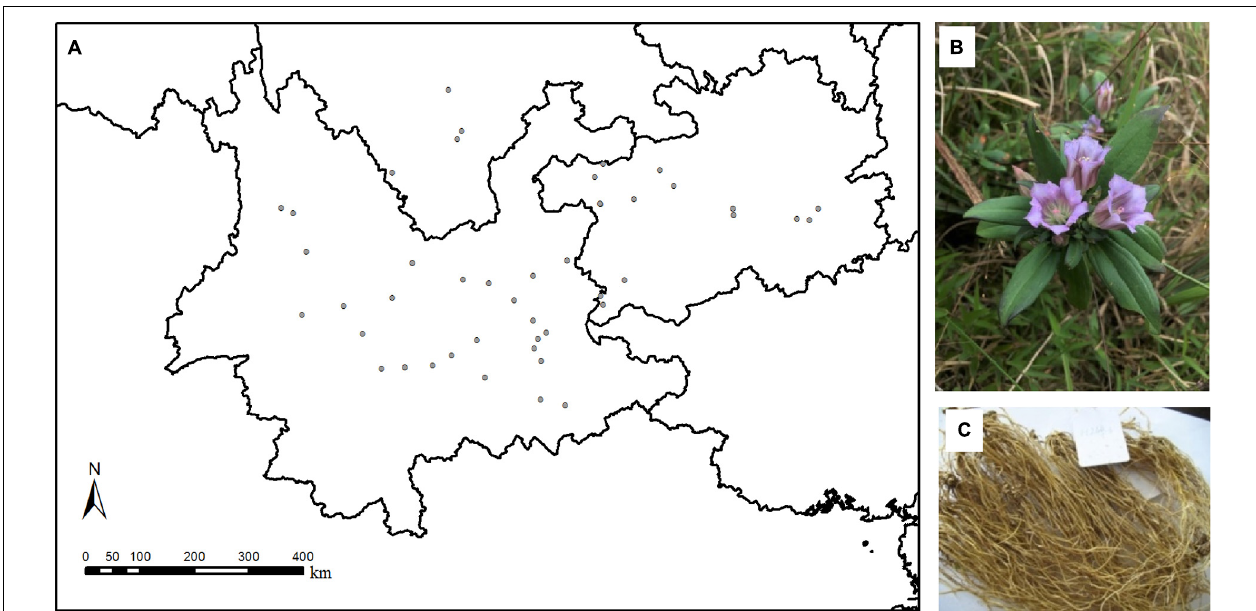
FIGURE 1 | Sampling sites and samples of Gentiana rigescens . (A) Sampling sites of the plant species in southwest of China. (B) Above-ground part of the plant species. (C) Below-ground part of the plant